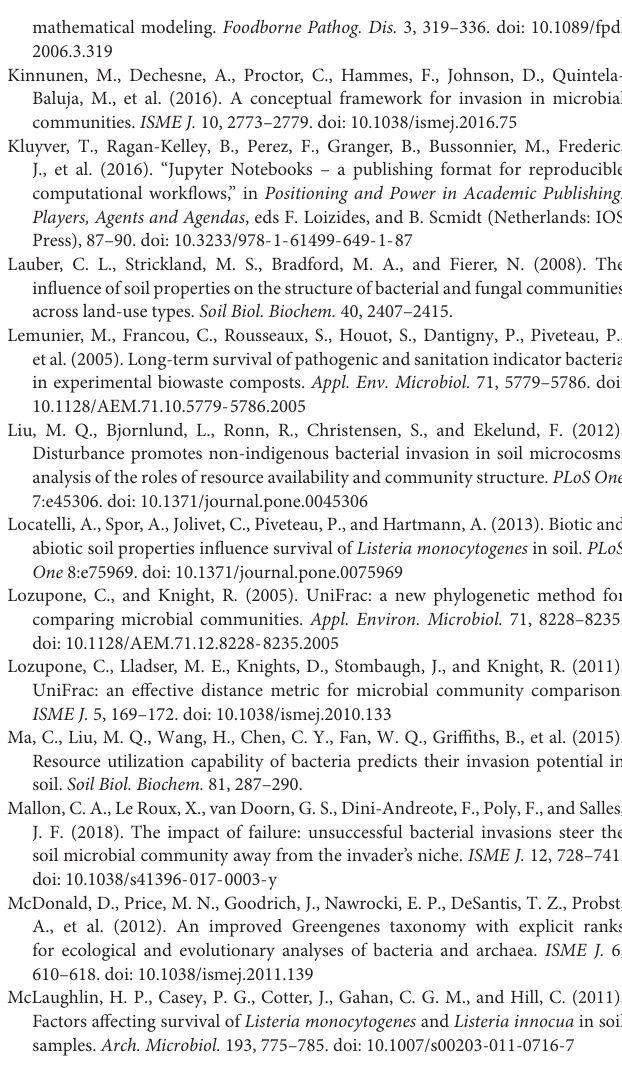
FIGURE S1 | Assessment of soil inoculum pre-treatment on the dynamics of L. monocytogenes during invasion of control and disturbed soil microcosms. FIGURE S2 | Bacterial α -diversity in soil microcosms facing ongoing invasion and under a regimen of disturbances, estimated by evenness index. FIGURE S3 | OTUs displaying significantly higher abundance in the treatment ColdT0/ColdT20 than in the treatment HeatT0/HeatT20 applied to soil E microcosms. After 16SrDNA gene diversity analysis, abundance of detected OTUs was compared between treatments. Rarefaction of all samples was set at 3500 sequences. The frequency of each OTU was determined after dividing the number of reads by 3500. Significance of OTUs with higher abundance was assessed